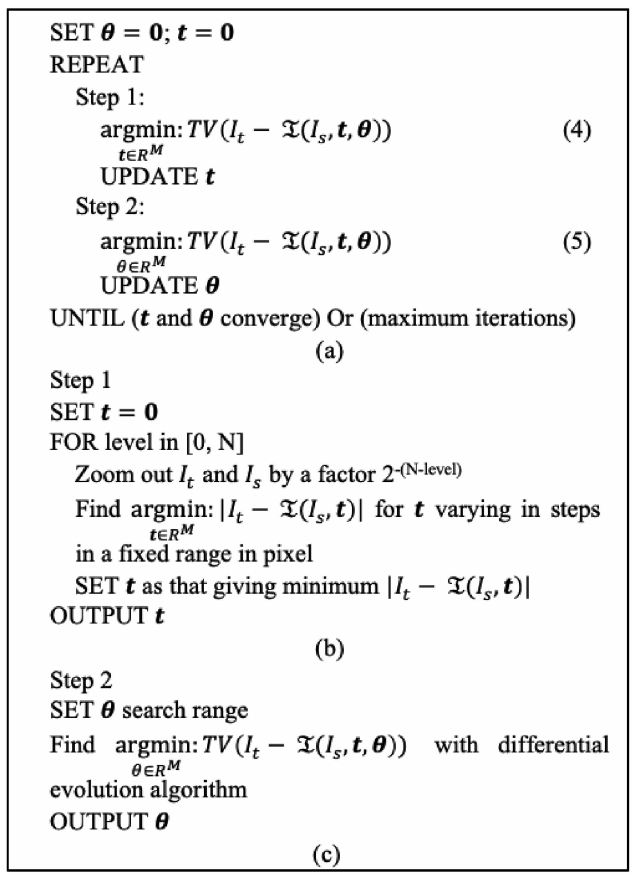
Figure 2 ( a ) Pseudocode for the minimization of equation (3) in 2D rigid-body registration. ( b ) Pseudocode for Step 1 in ( a ). ( c ) Pseudocode for Step 2 in ( a